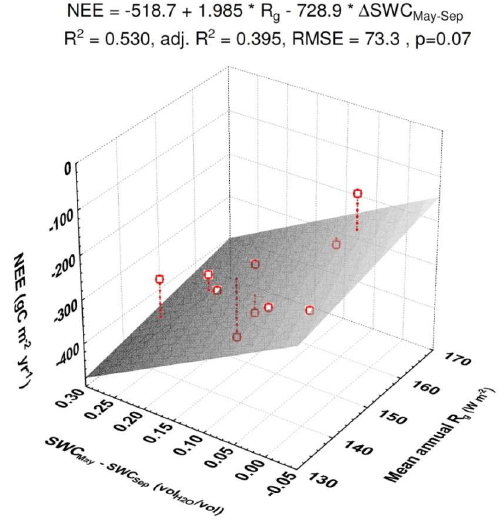
Figure A3. 3D scatter plot of NEE versus ΔSWC May – Sep and mean annual solar radiation R g .